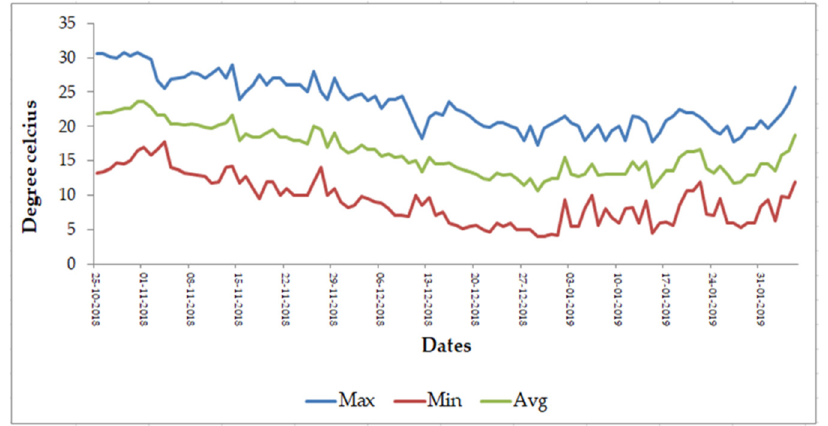
Figure 10. Temperature profile (maximum (Max), minimum (Min) and average (Avg)) from sowing to onset of flowering in outdoor environment at the experimental site.